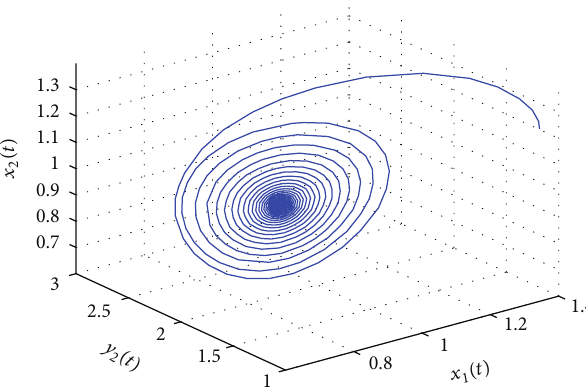
Figure 2: The phase plot of the states 𝑥 1 , 𝑥 2 , 𝑦 2 for 𝜏 1 = 4.2500 < = 4.5061 𝜏 10